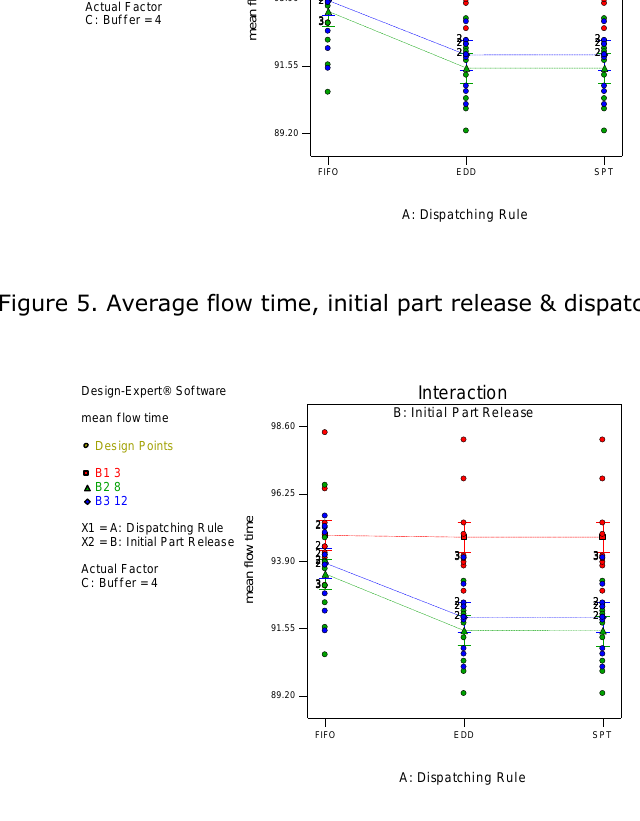
Figure 6. Average flow time, initial part release & dispatching